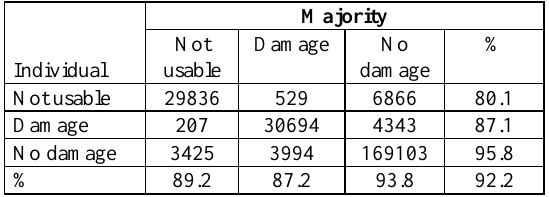
Table 2. Error matrix for agreement of individual volunteer ratings with the majority classification of all volunteers for images in the Hurricane Matthew Picture Pile campaign